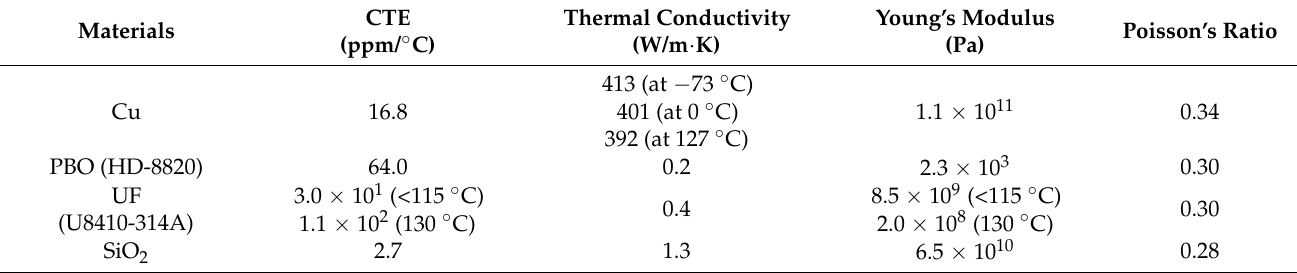
Figure 3. ( a ) Typical cross-sectional FIB image of the Cu-Cu joints. ( b ) The established FEM model. ( c ) Detailed geometry of the 3D bump models. Table 1. Material properties used in the FEM models